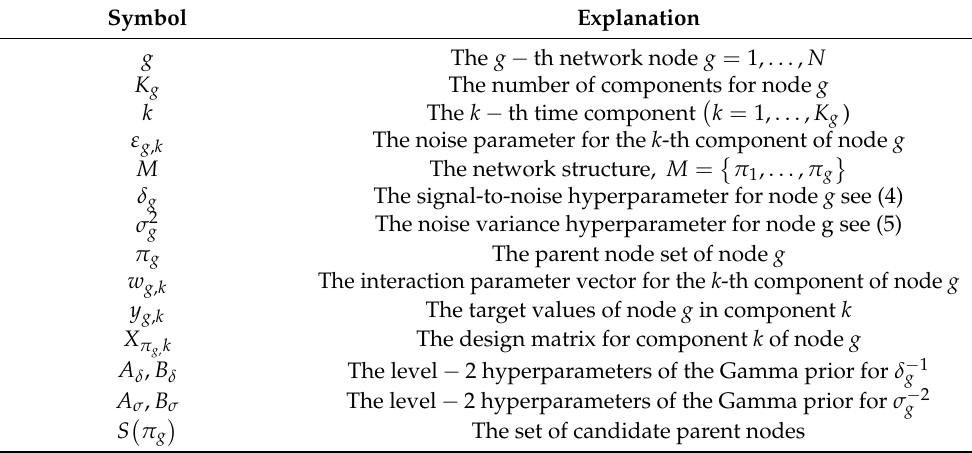
Table 1. Hyperparameters and symbols.